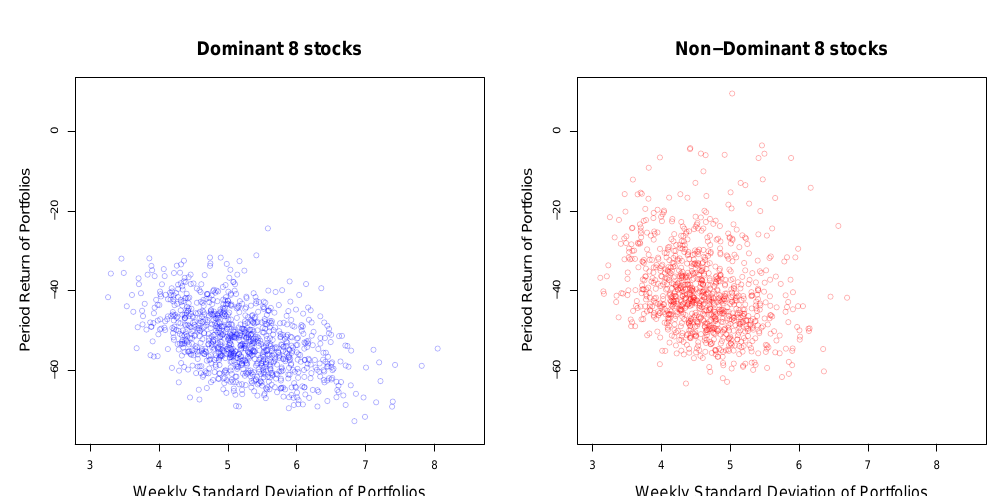
Figure 9. Scatter plots of Period 4 returns against the weekly volatility for the eight-stock portfolios selected on the basis of the clusters identified in neighbor-Nets splits graph from Period 3 with the clusters split into dominant and non-dominant industry